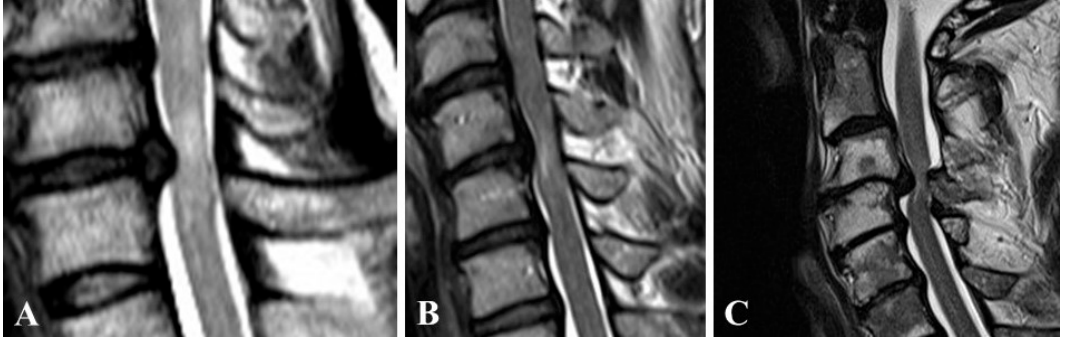
Figure 1. Cervical Myelopathy in a patient of G1 ( A ), G2 ( B ) and G3 ( C ). Table 1. Clinical parameters of the treated patients; m: male; f: female. G1 G2 G3 p -Value